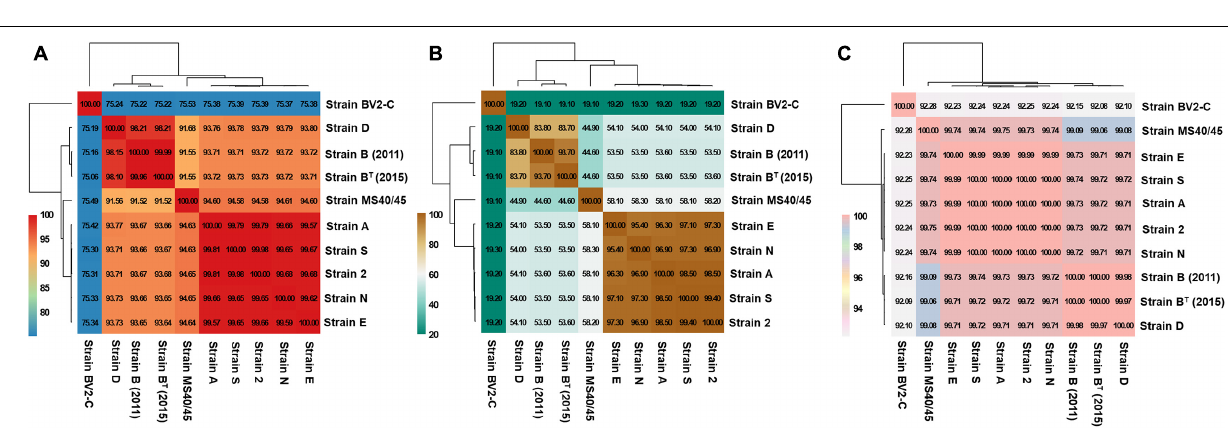
FIGURE 3 | Heatmaps representing the hierarchical clustering of Chloracidobacterium spp. strains based on genomic distances for the evaluation of species circumscription. The extent of nucleotide identity was calculated according to different indices: (A) Average Nucleotide Identity calculated by BLAST (ANIb); (B) digital DNA-DNA hybridization (dDDH); and (C) tetranucleotide frequency (TETRA) as shown. Values in boxes indicates the percentage of genomic relatedness for each metric. Colors indicate strains with similar percent identity values. The heatmap was generated in R package plots using the heatmap.2